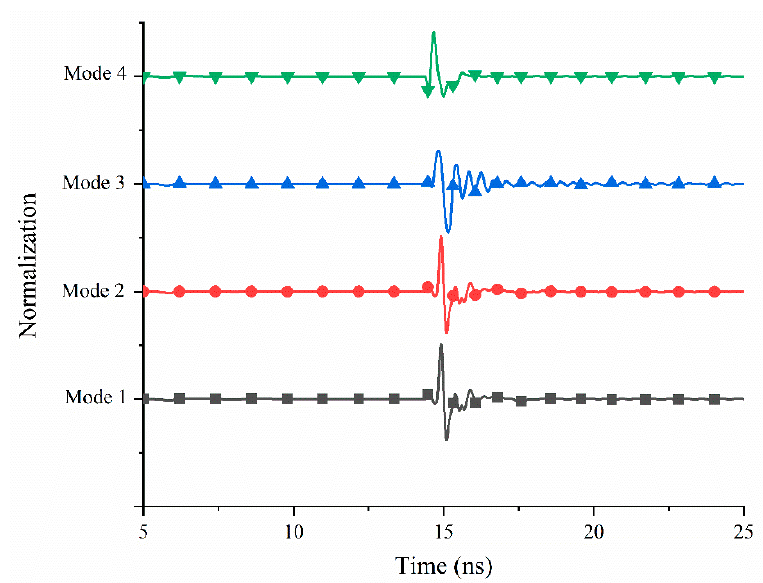
Figure 14. Calculated pulse shapes for each mode at the received antenna output from the measurements.